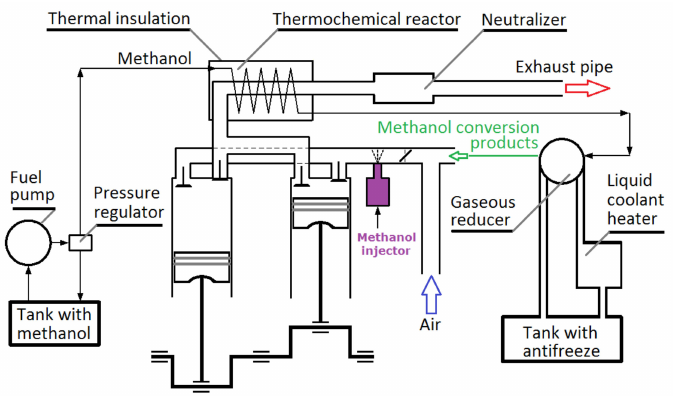
Figure 3. Scheme of the experimental stand based on the diesel engine D21A1 for study parameters of its work of methanol conversion products.